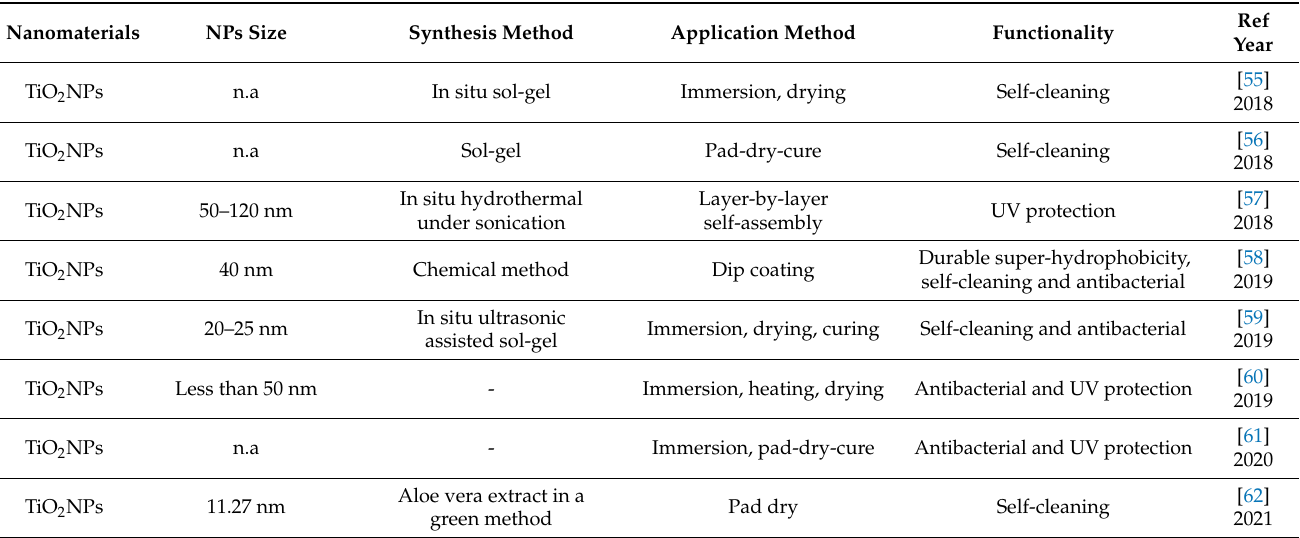
Table 2. A list of the functionalization of cotton fabrics integrated with TiO 2